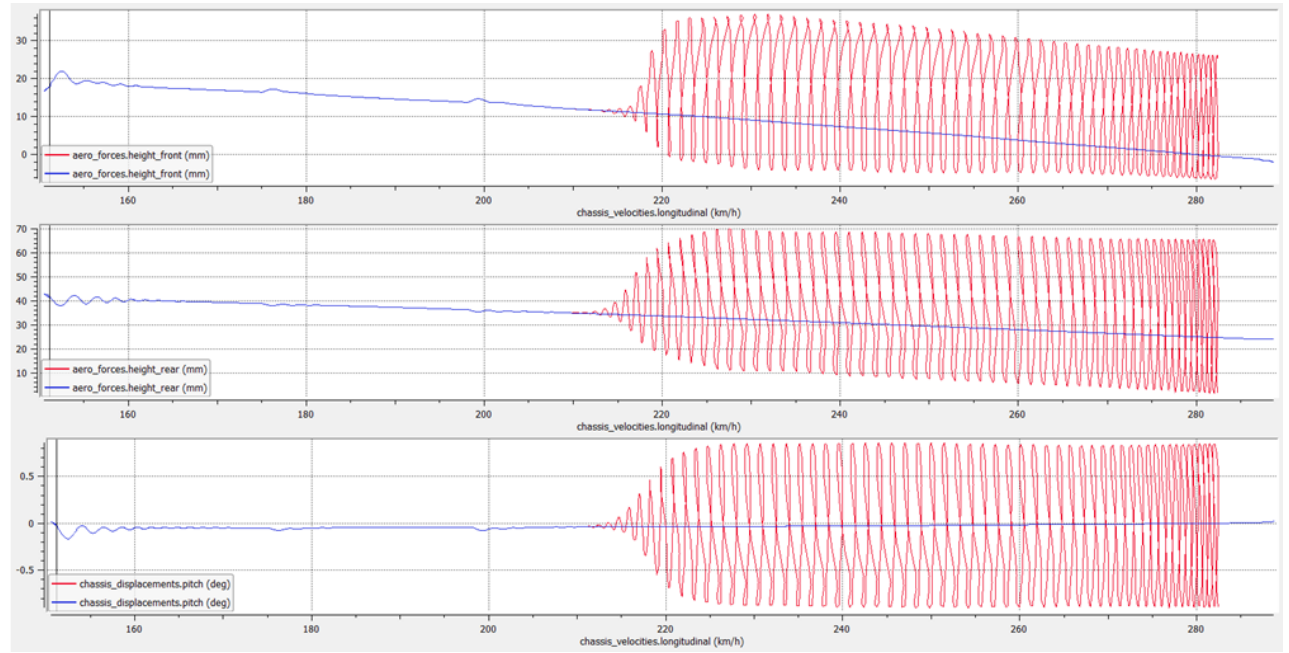
Figure 16. Plots showing vehicle motion with baseline aero maps (#1, blue) and with the application of decay functions (#2, red) along a quasi-static straight-line maneuver with increasing speed. Porpoising is triggered at around 210 kph, with the rear axle coming first and dominating in terms of amplitude. Pitch oscillates with an amplitude above 1 degree and a consistent frequency around 6 Hz.